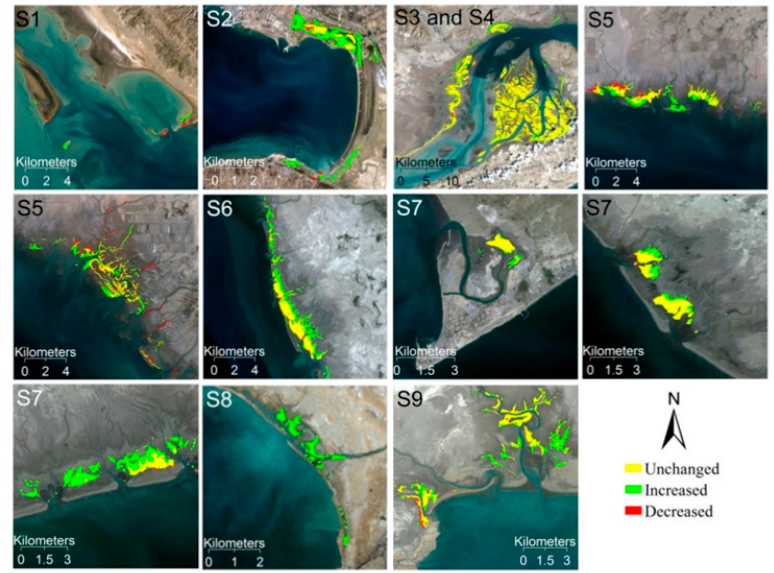
Figure 7. Spatiotemporal changes of mangrove forests in all major mangrove sites (S1–S9 in Figure 1) on SMRI images between 1990 and 2020 in southern Iran.